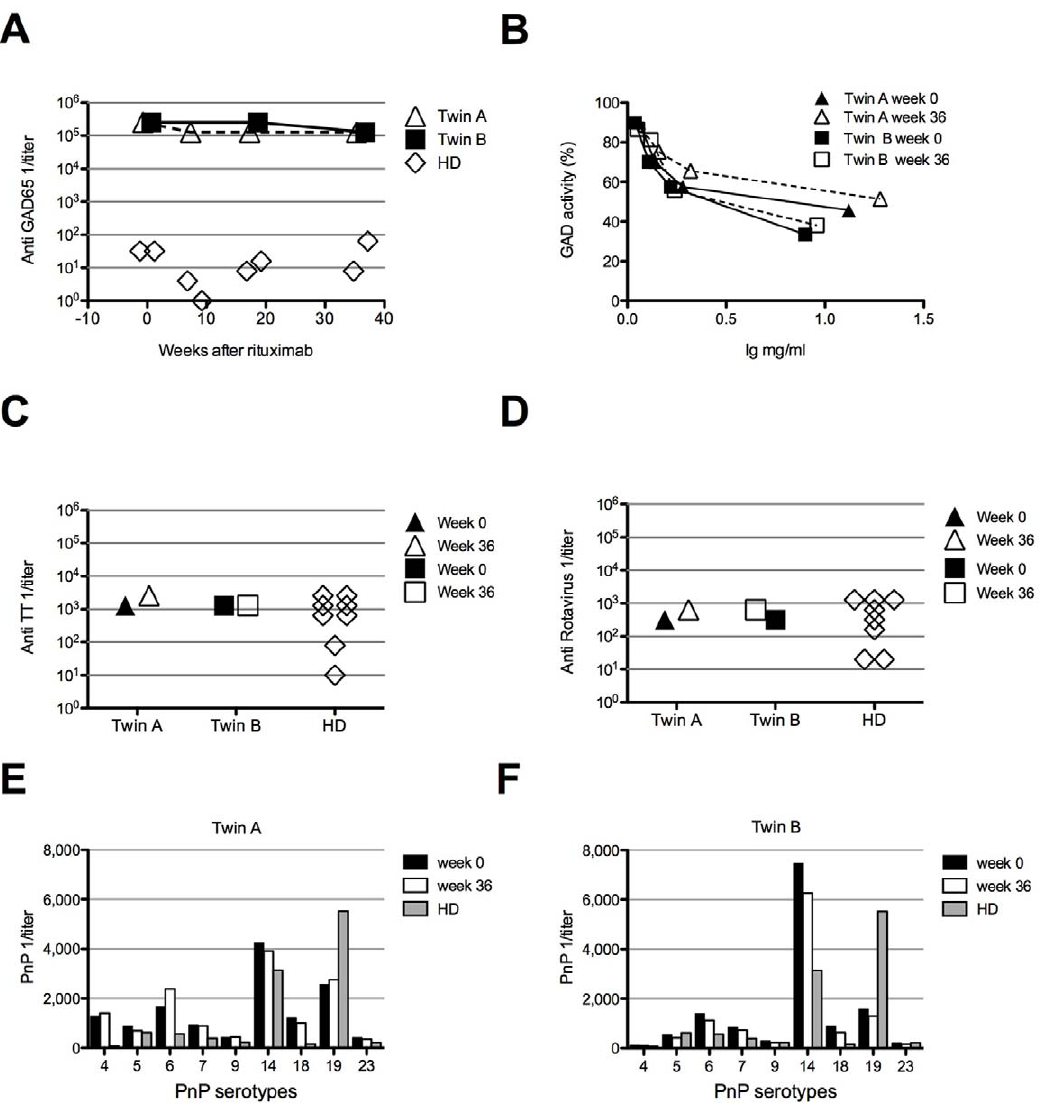
Figure 1. A portion of antibodies in SPS patients is not influenced by rituximab treatment. Rituximab treatment induces a 2-fold decrease of GAD65 specific serum antibody titer. (A) Serum samples from twin A and twin B were collected before and 8, 16, 36 weeks after rituximab treatment, and GAD65 specific antibody titers were measured by ELISA. The titers of 8 healthy donors ranged between undetectable and 1/80. (B) Inhibition of GAD65 enzyme activity was tested with IgG of twin A and twin B isolated at week 0 and 36 after starting the anti-CD20 treatment. (C,D) TT and Rotavirus antibody titers. Serum from twin A and twin B was collected at week 0 and 36 post rituximab treatment, and antibody titer was measured by ELISA. Eight healthy donors (HD) were used as controls. (E, F) Pneumococcal polysaccharide (PnP) antigens antibody titers in twin A (E) and in twin B serum (F), at week 0 and 36 post treatment, x axes show the different PnP antigens tested.